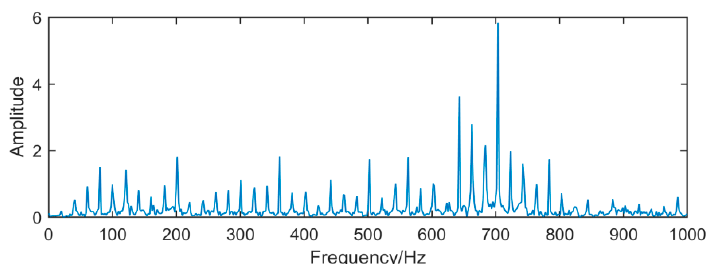
Figure 15. Frequency domain waveform of the fault signal.